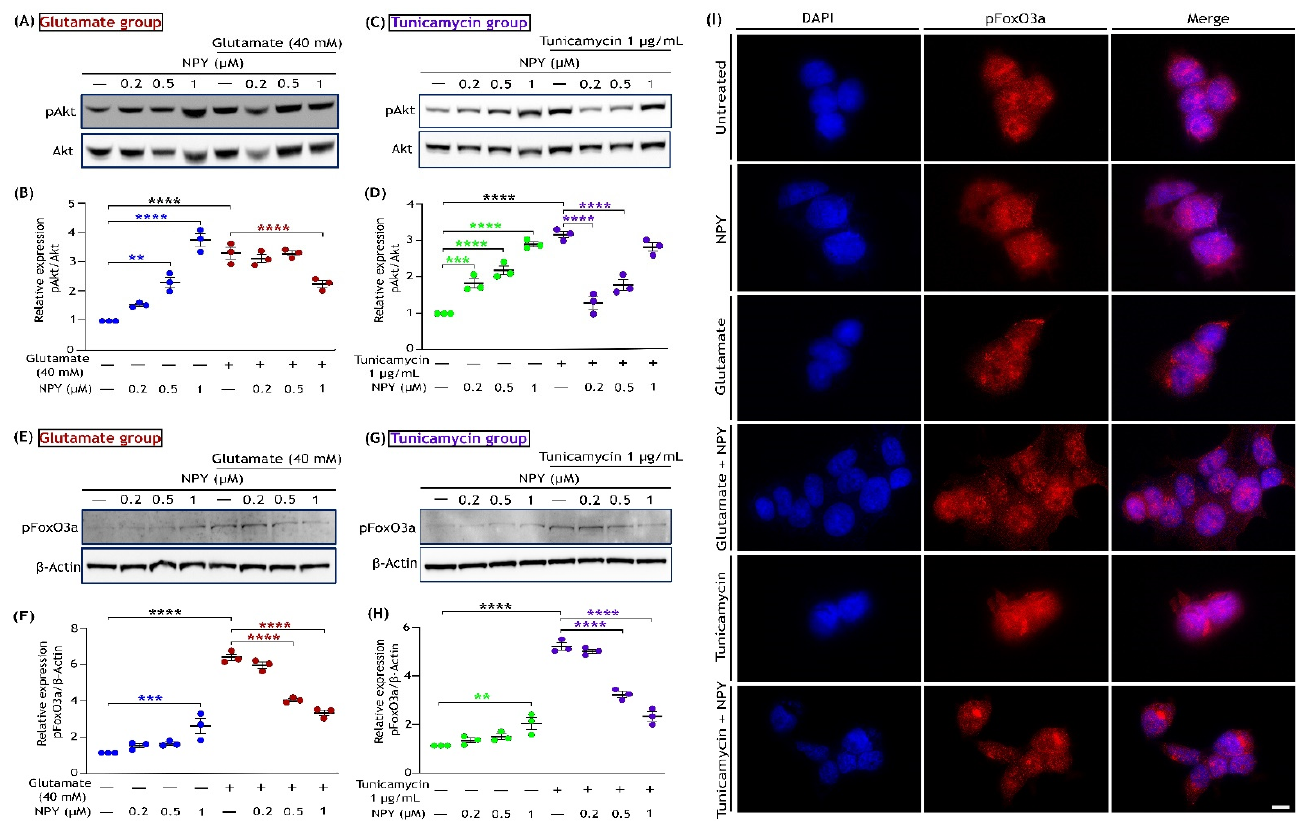
Figure 6. NPY reduces the activation of the Akt/FoxO3a axis triggered by oxidative stress under glutamate and tunicamycin in SH-SY5Y cell cultures. Western immunoblot analysis and densitometric quantification of AKT phosphorylation (Ser473) ( A , B ) with glutamate and tunicamycin ( C , D ) treat- ments at 12 h reveal a significant increase in AKT activation with glutamate/tunicamycin compared to the control group (F(1,16) = 69.66 in Figure ( B ) and F(1,16)= 12.93 in Figure ( D ), **** p < 0.0001, n = 3) and NPY treatment significantly decreases this activation (F(3,16) = 15.36, ** p < 0.01, **** p < 0.0001 represents significance between control and NPY group (blue), **** p < 0.0001 represents significance between glutamate and glutamate + NPY in Figure ( B ) (red), n = 3; F(3,16) = 44.88, *** p < 0.001, **** p < 0.0001 represents significance between control and NPY group (green), **** p < 0.0001 represents significance between tunicamycin and tunicamycin + NPY in Figure ( D ) (purple), n = 3). Western immunoblot analysis and densitometric quantification of FoxO3a phosphorylation (Ser 253) ( E , F ) with glutamate and tunicamycin ( G , H ) treatment at 12 h reveal a significant increase in FoxO3a activation with glutamate/tunicamycin compared to the control group (F(1,16) = 550.6 in Figure ( F ) and F(1,16)= 577.2 in Figure ( H ), **** p < 0.0001, n = 3) and NPY treatment significantly decreases this activation (F(3,16) = 12.99, *** p < 0.001 represents significance between control and NPY group (blue), **** p < 0.0001 represents significance between glutamate and glutamate + NPY in Figure ( F ) (red), n = 3; F(3,16) = 26.45, ** p < 0.01 represents significance between control and NPY group (green), **** p < 0.0001 represents significance between tunicamycin and tunicamycin + NPY in Figure ( H ) (purple), n = 3). Each band intensity of phospho-FOXO3a was normalized to the respective band intensity of β -actin. ( I ) Immunofluorescence images (representative) of treated SH-SY5Y cells showing the expression of phosphorylated FoxO3a. After 12 h of treatment, cells were fixed and immunostained with anti-phospho-FoxO3a (Ser253) antibody (red). Nuclei were stained with DAPI (blue). Scale bar= 10 µ